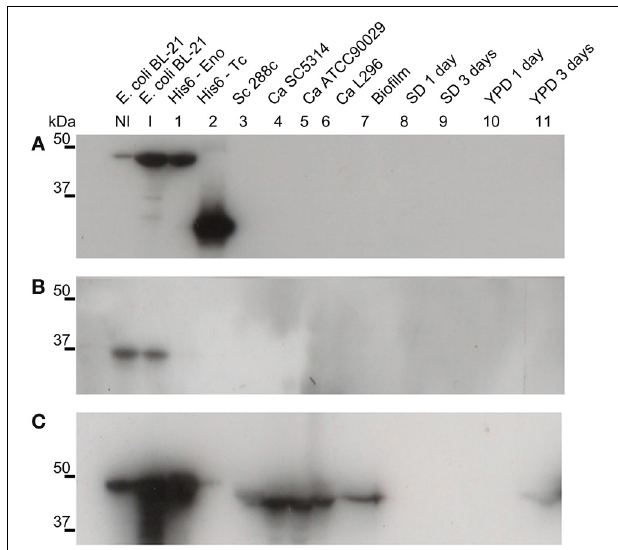
FIGURE 1 | Native enolase is recognized in C. albicans cell lysates, biofilm and supernatant of conditioned rich medium. Western blots of enolase in biofilm and cell lysates of different C. albicans strains, according to: NI, non-induced E. coli BL-21 lysate; I, E. coli BL-21 expression induced for 2h at 37 ◦ C lysate; 1, recombinant His 6 -enolase; 2, His 6 - T. cruzi 30kDa protein used as control; 3, S. cerevisiae 288c cell lysate; 4, C. albicans SC5314 cell lysate; 5, C. albicans ATCC90029 cell lysate, 6, C. albicans L296 cell lysate; 7, C. albicans SC5314 biofilm matrix concentrated 500 times; C. albicans SC5314-conditioned medium are respectively: 8, minimal medium with 24h growth; 9, minimal medium with 72h growth; 10, YPD with 24h growth; and 11, YPD with 72h growth. (A) anti-His 6 antibody (dilution 1:1000), shows the recognition of the recombinant protein of His 6 - T. cruzi and the His 6 -enolase, confirming its proper purification; (B) pre-immune rabbit serum (1:500), showing no recognition of fungal proteins and recognition of a non-specific low molecular weight band (below 37kDa) within the E. coli extracts; and (C) anti His 6 -enolase (1:2000), showing recognition of the recombinant enolase and native protein in biofilms, cell lysates and spent medium.